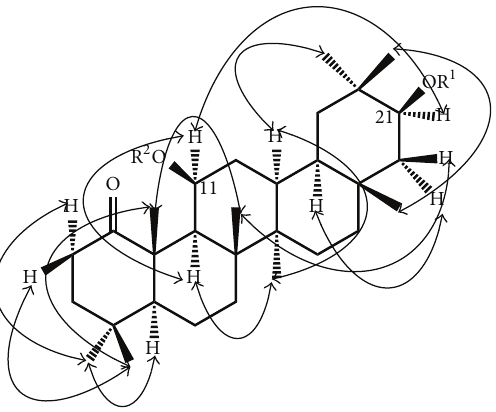
Figure 3: NOESY interaction in compounds 1 – 5